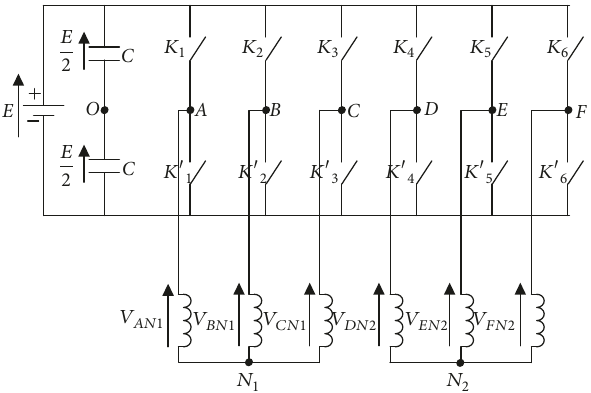
Figure 1: Structural diagram of an inverter double star.